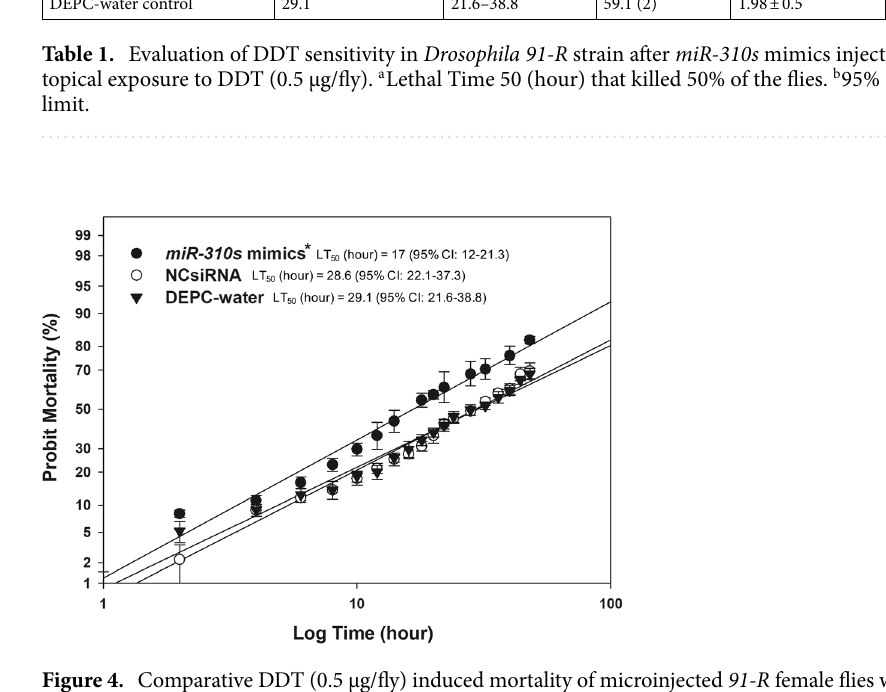
Figure 4. Comparative DDT (0.5 μg/fly) induced mortality of microinjected 91-R female flies with miR-310s mimics, negative control siRNA mimic (NCsiRNA), and DEPC-water. There was no difference between the DEPC-water and NCsiRNA microinjection groups ( p = 0.263). The Fisher F -test was performed to verify if the regression lines were equal to each other. An asterisk (*) indicates a difference across the treatment groups at p < 0.05. 95% CI: 95% Confidence